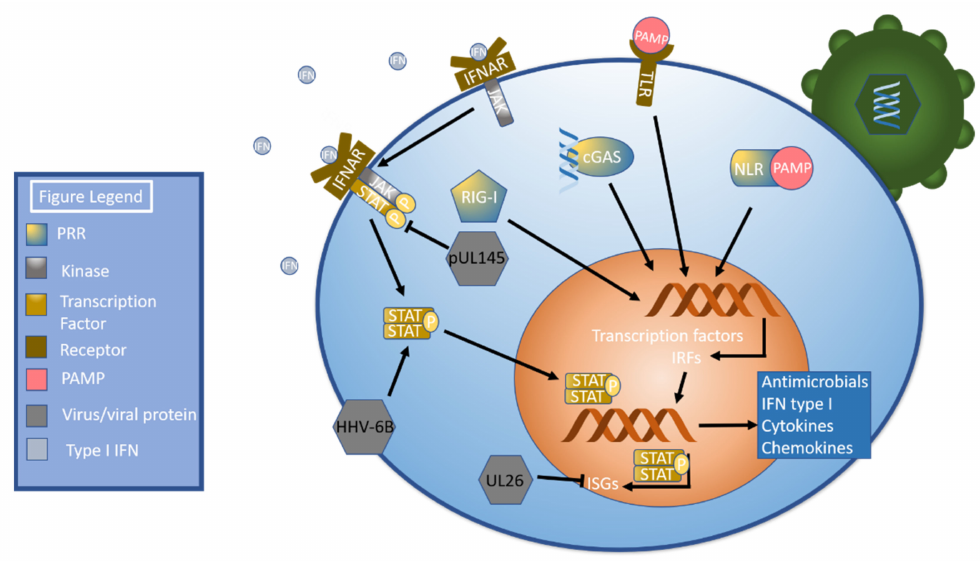
Figure 1. Pathogen Sensing, Interferon (IFN), and the JAK-STAT Pathway. Pathogen invasion triggers several pattern recognition receptors (PRRs), including NOD-like receptors (NLRs), RIG-I -like recep- tors (RIG-I), cGAS, and TLRs (toll-like receptors). These PRRs activate signal transduction pathways that culminate in the production of transcription factors and interferon regulatory factors, which in turn leads to the production of antimicrobial peptides, proinflammatory cytokines, chemokines, and type I IFN. Type I IFN then binds to the interferon α receptor (IFNAR), which phosphorylates JAK. Phosphorylated JAK recruits STAT, which is then phosphorylated, dimerizes, and translocates to the nucleus. Once in the nucleus, STAT upregulates the transcription of ISGs. The HCMV protein pUL145 inhibits STAT, while HHV-6B has been shown to upregulate STAT. The HCMV protein UL26 inhibits ISGs and